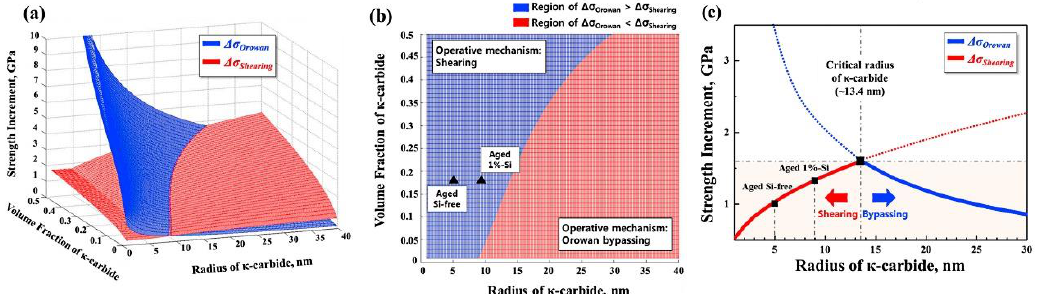
Figure 8. Relationship between operative deformation mechanism (as the lowest strength increment),